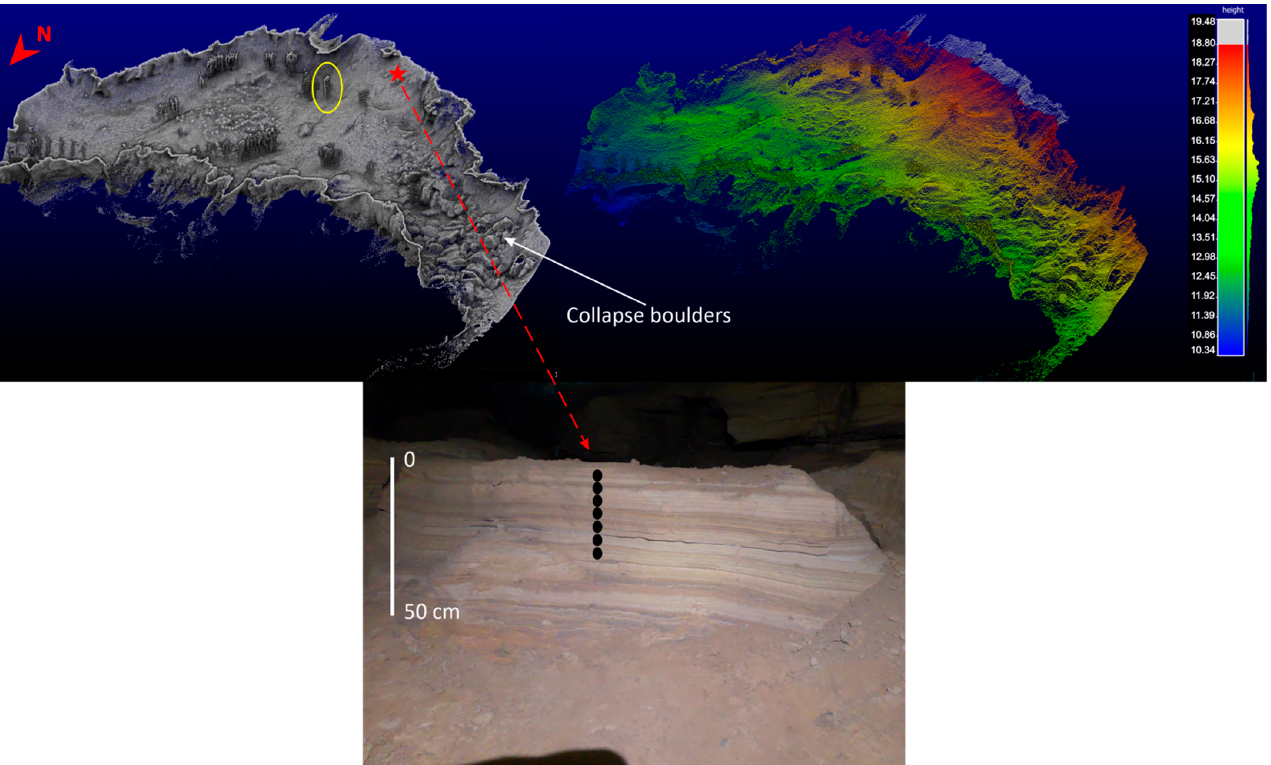
Figure 4. View of the chamber where the fine-grained cave deposits were sampled (upper images, after 3D mapping). The red star depicts the exact deposit site. View of the passage with its height distribution in a color scale (upper right image). The fine-grained deposits and corresponding sampling points are depicted with black circles (bottom image).The yellow ellipse indicates the figure of the researcher operating the 3D scanner.